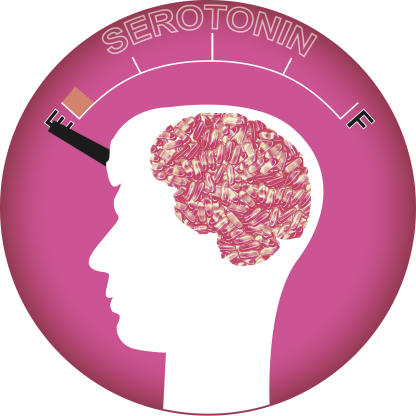
(Illustration: Margaret Shear, Public Library of Science)